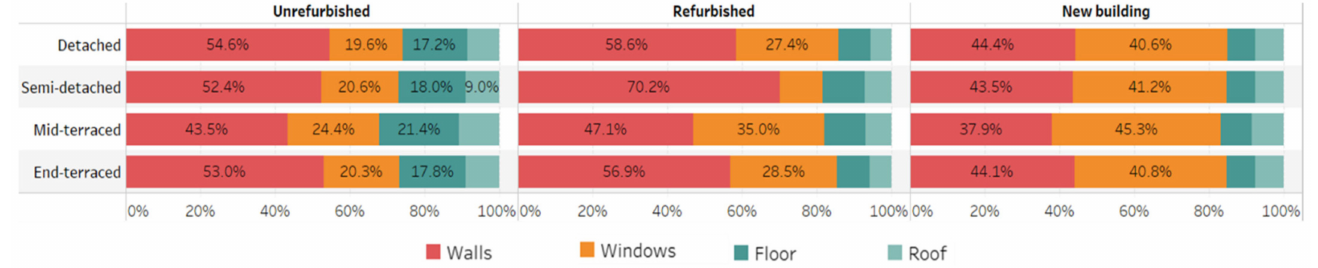
Figure 3. Contribution of construction components to fabric heat loss.